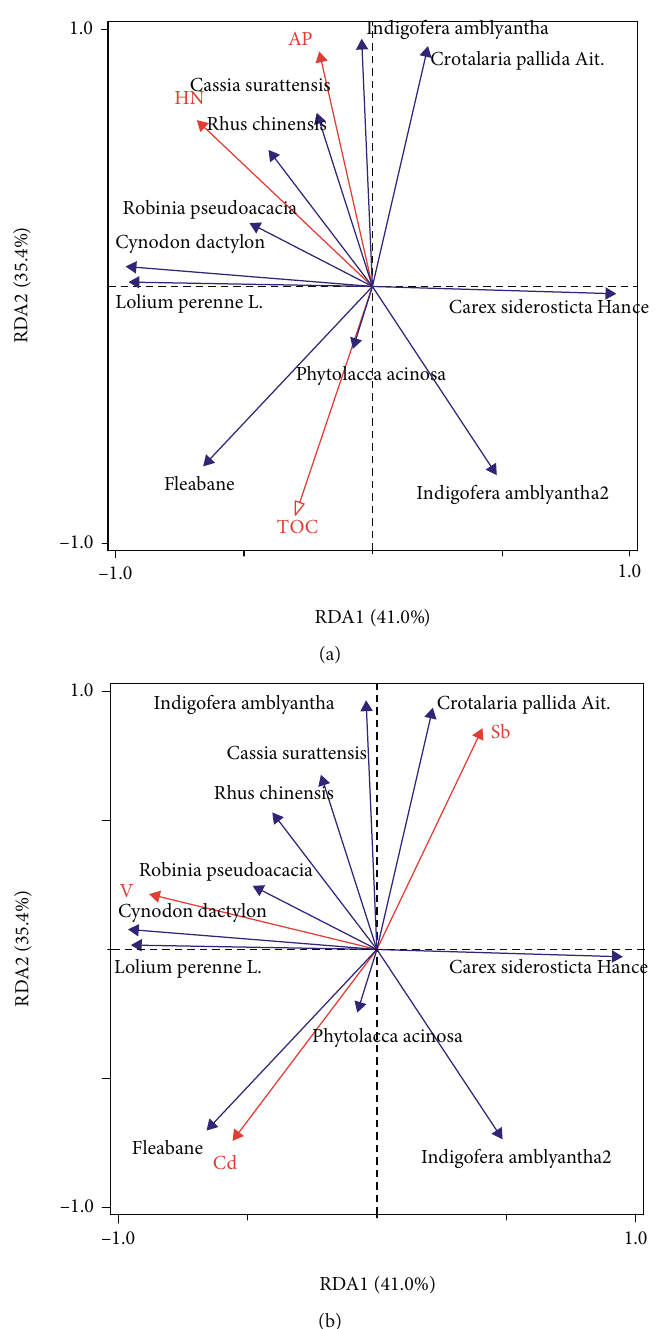
Figure 4: The RDA ranking diagram of species importance values and factors in substrate material. (a) nutrient factors and (b) heavy metals in the arti fi cial soil matrix. Solid arrows represent species information and hollow arrows represent environmental factors. The testing and stepwise selection method: summarize e ff ects of explained variables and unrestricted